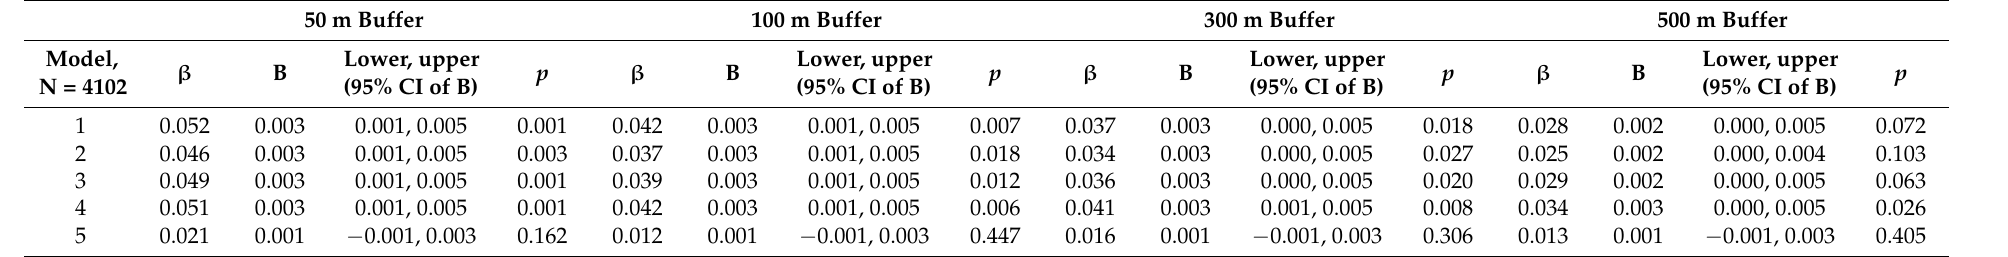
Table 7. Associations between residential greenspace at 50 m, 100 m, 300 m, and 500 m buffers, and life satisfaction (subsample: